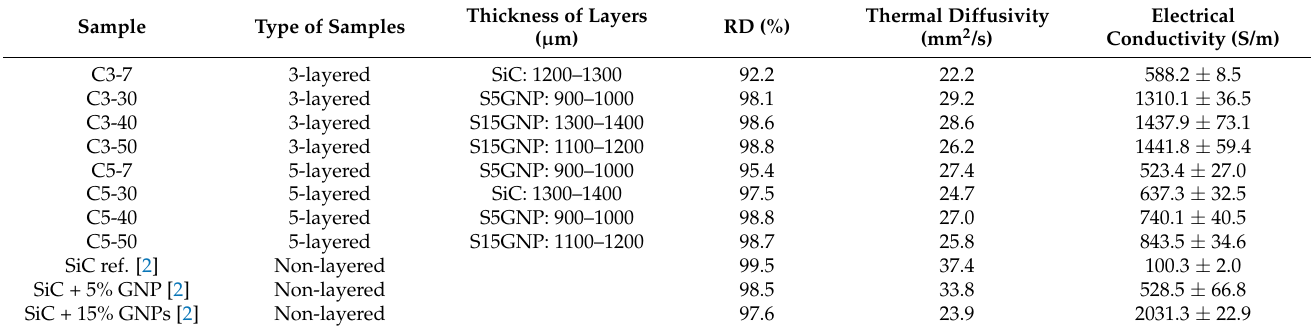
Table 1. Properties of all layered materials and reference, non-layered materials.